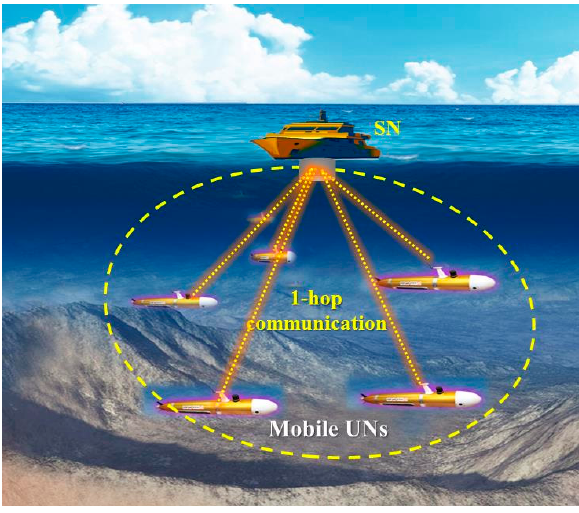
Figure 1. Network model.